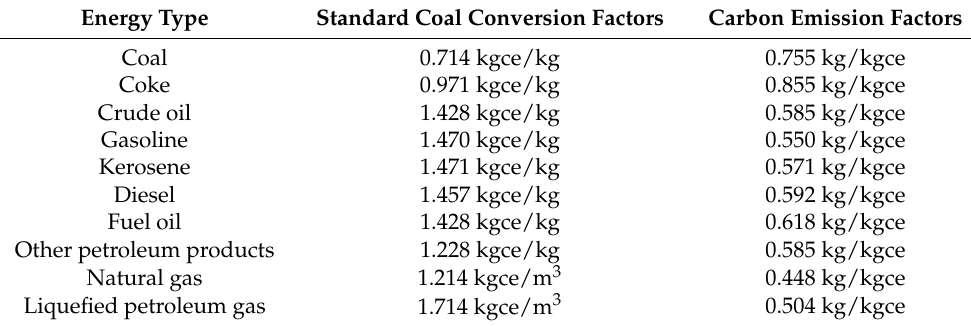
Table 1. Standard coal conversion factors and carbon emission